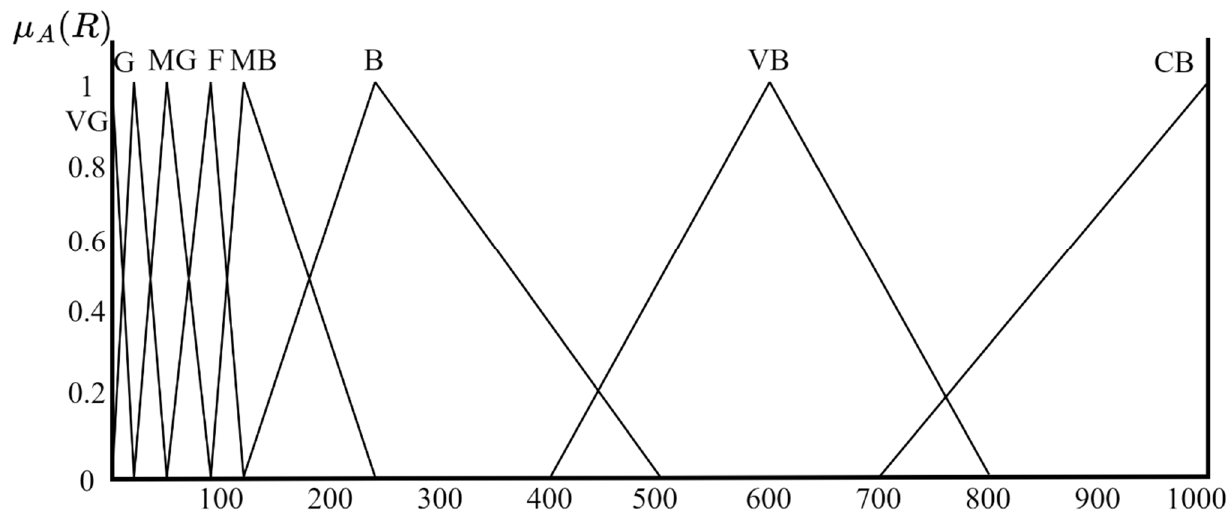
Figure 6. Membership functions of output variables.